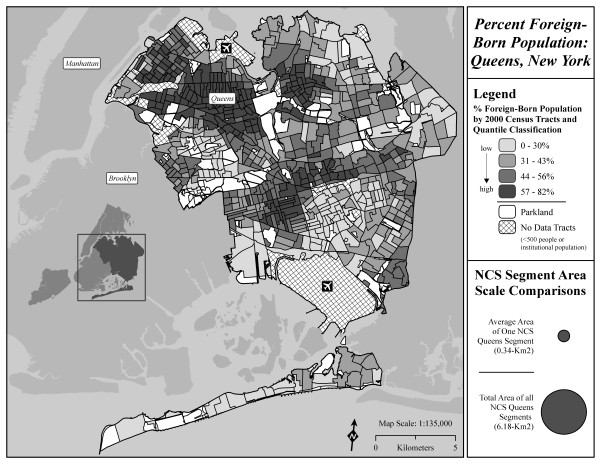
Distribution of percent foreign-born population in Queens Census tracts. In comparison to the area of Queens (281.59 km2) shown on the map, the circles in the legend of the maps represent the total area of the 18 segments (middle circle - 6.18 km2) and the average area of a Queens NCS segment (smallest circle – 0.34 km.2).